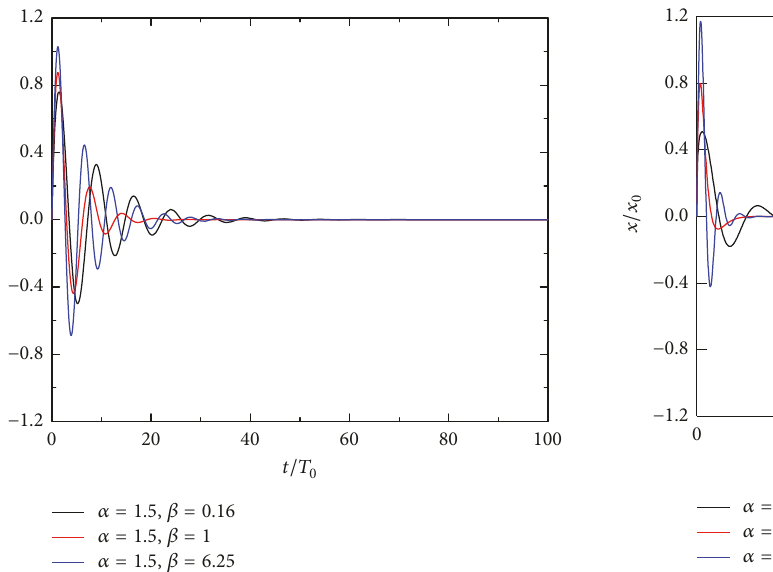
Figure 33: Response in the time domain ( 𝛼 = 1.5, 𝛽 = 0.16, 1, 6.25 ).